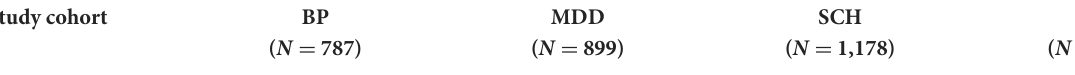
TABLE 2 Treatment information, clinical outcome and post-treatment MCCB